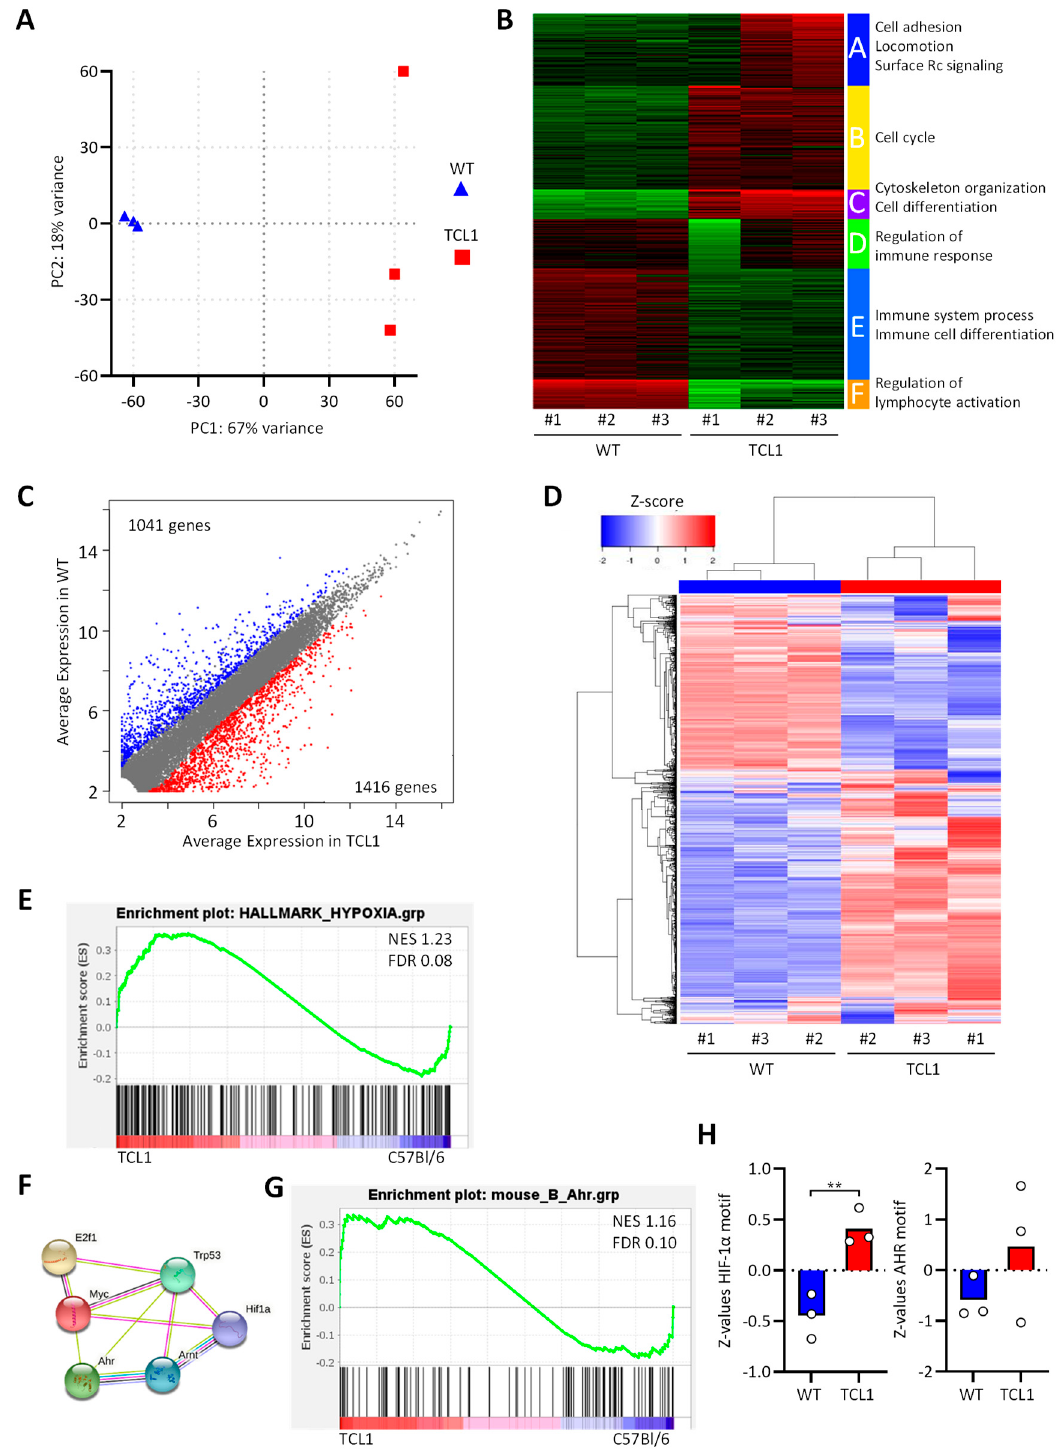
Figure 1. RNA sequencing of B cells from C57BL/6 and Eµ-TCL1 mice. Splenic B cells were FACS-sorted from three mice of each genotype, and mRNA was sequenced. ( A ) Principal component analysis of individual animals. ( B ) K-means clustering and Gene Ontology enrichment analysis. ( C ) Scatterplot depicting the expression of genes in the groups. ( D ) Unsupervised hierarchical clustering showing 1416 genes upregulated and 1041 genes downregulated in TCL1. ( E , G ) Gene Set Enrichment Analysis showing the enrichment of hypoxia ( E ) and AHR ( G ) signatures in Eµ-TCL1 versus C57BL/6 mice. ( F ) Protein–protein interactions network (STRING) for transcription factors involved in enriched hallmark pathways (GSEA). ( H ) Transcription factor activity (Z-values, ISMARA) for HIF-1 α and AHR motifs in WT and TCL1 B cells.